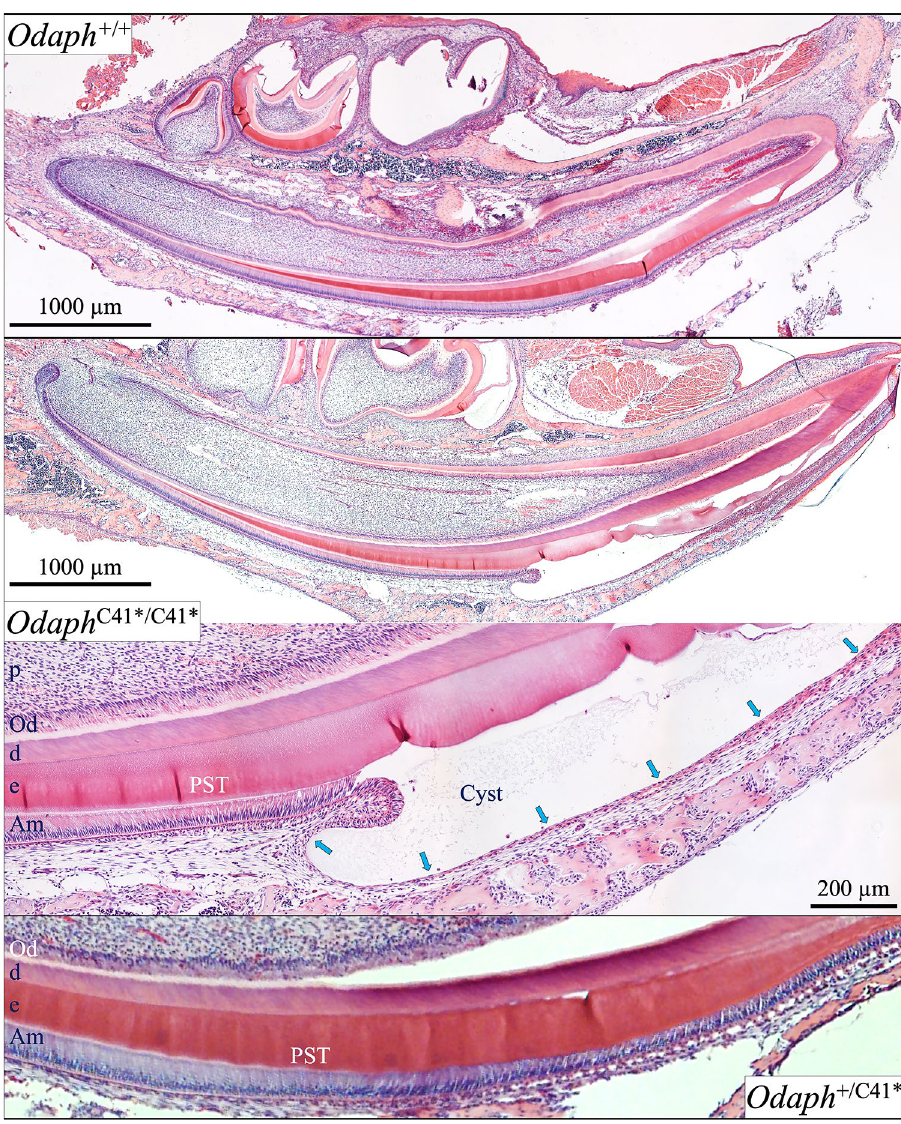
Figure 3. Odaph +/+ , Odaph +/C41* , and Odaph C41*/C41* Mandibular Incisor Histology at D12. Incisor sagittal sections provide histological information on all stages of enamel formation, including differentiating, presecretory, secretory, transition and maturation ameloblasts. The Odaph +/C41* incisors (bottom) resembled those of the wild-type (top). The Odaph C41*/C41* incisors appeared to be normal until late in